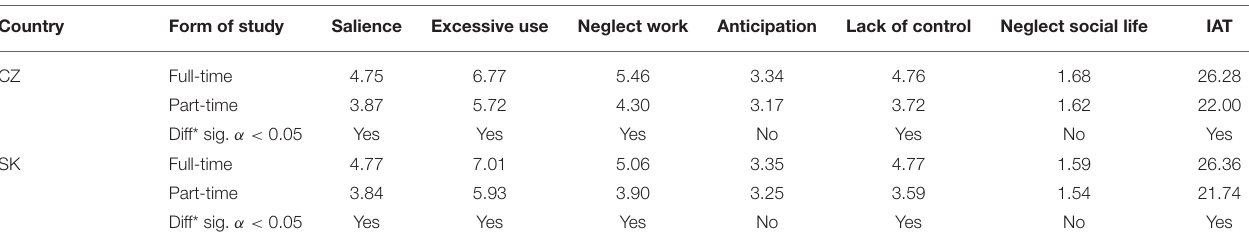
TABLE 8 | Mean values of the IAT and its subscales in the classification by form of study. Country Form of study